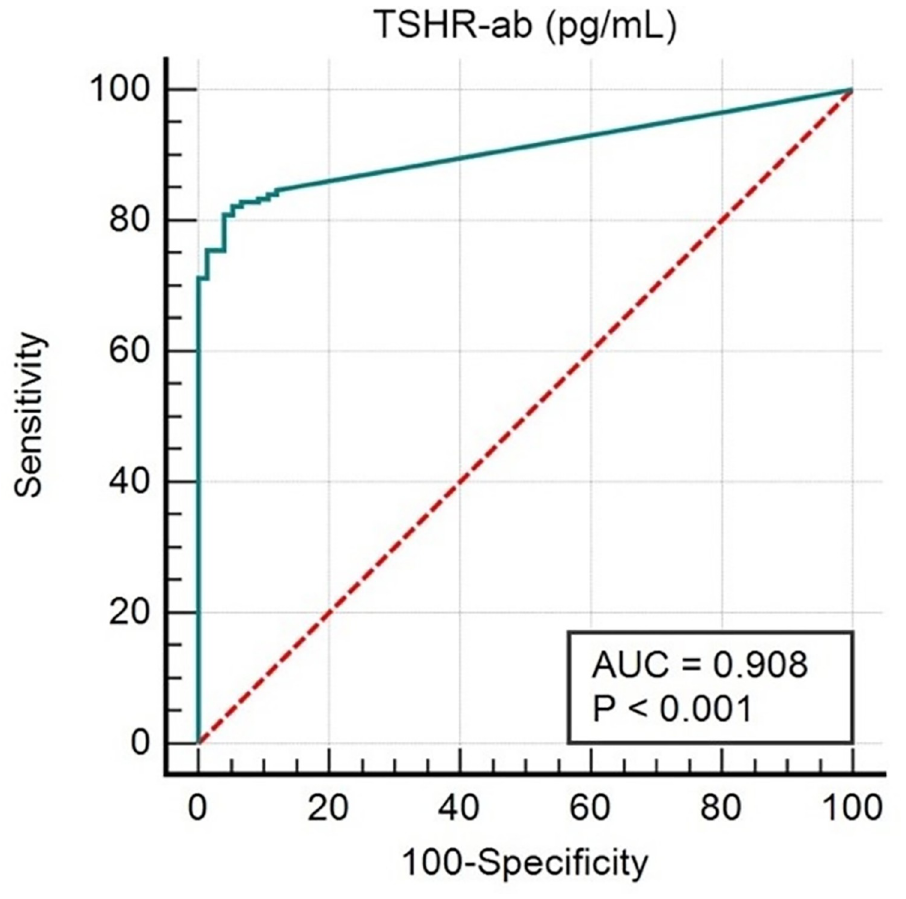
Fig 3. ROC curve analysis comparing TSHR-ab between GO and GD vs. controls. Cutoff value > 106.04 pg/mL. Area under the ROC curve (AUC) = 0.908. (95% CI, 0.864–0.942), p < 0.0001. Positive percentage agreement (PPA) or. Sensitivity = 80.98% (95% CI, 74.1–86.7). Negative percentage agreement (NPA) or Specificity = 96.0 (95% CI, 88.8– 99.2). Youden Index J =